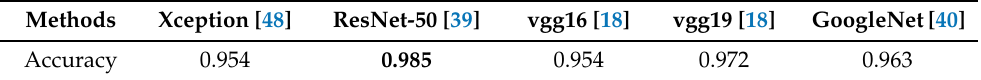
Table 6. Performance comparison of PCB parts : soldered pin dataset.